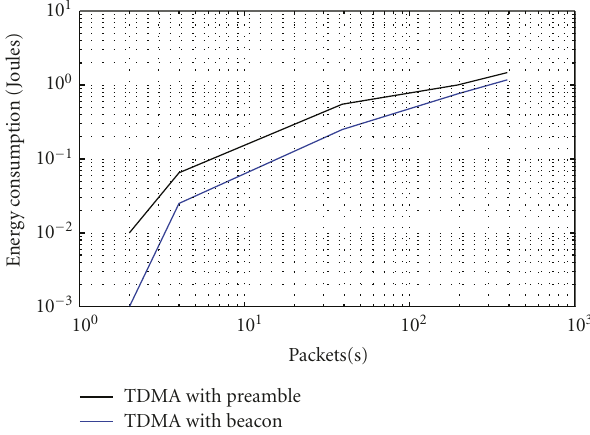
Figure 11: Power consumption of TDMA protocol with a preamble and a